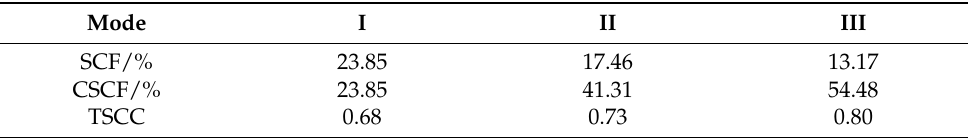
Table 2. The first three modes of SVD analysis and their SCF, CSCF, and TSCC between HMA winter snow depth and spring scPDSI in the